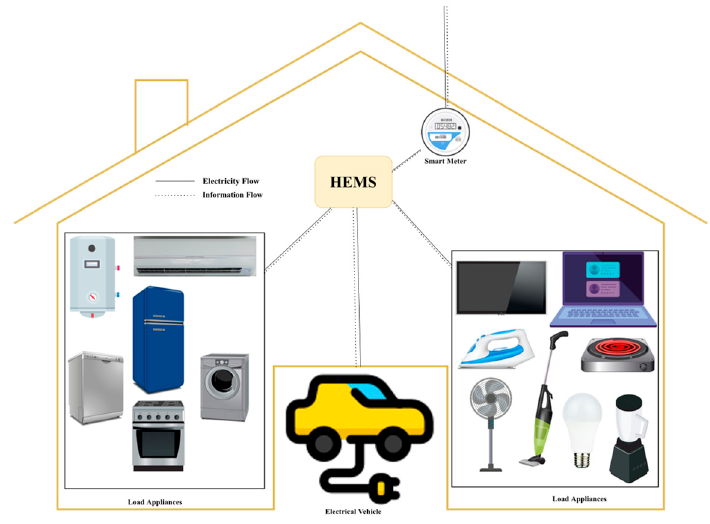
Figure 2. Smart home integrated with smart meter technology. All load appliances in each home are equipped with smart energy meters and are